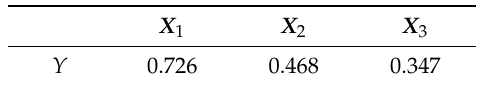
Table 1. Correlation coe ffi cients between the daily tourist flow of tomorrow and each element of the historical tourist